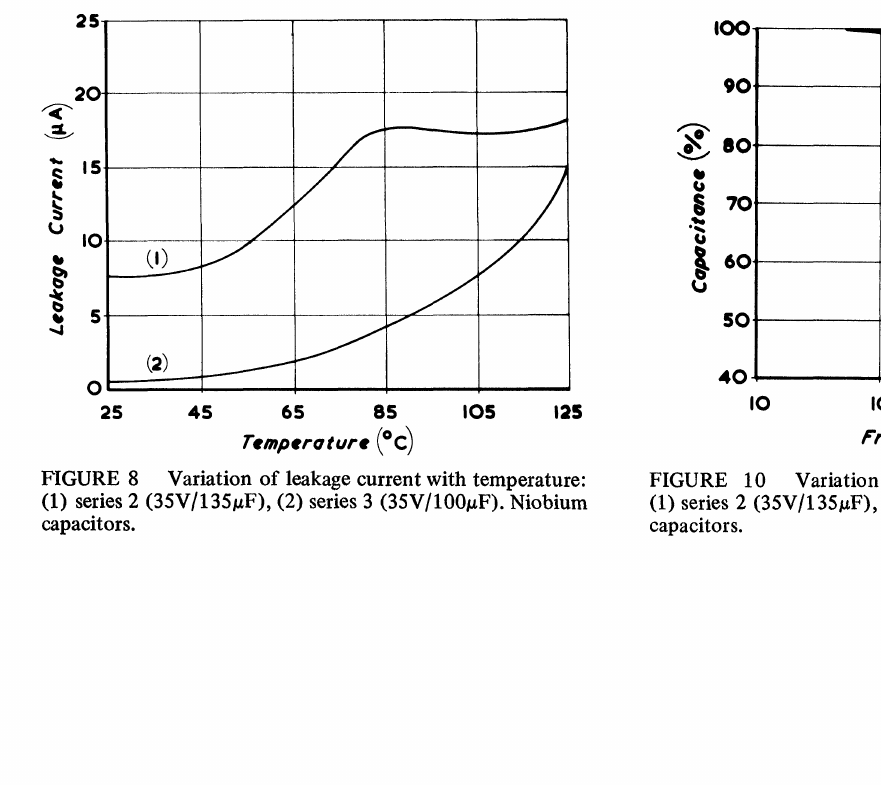
Variation of capacitance with temperature: (1) series 2 (35V/135#F), (2) series 3 (35V/100#F). Niobium capacitors.